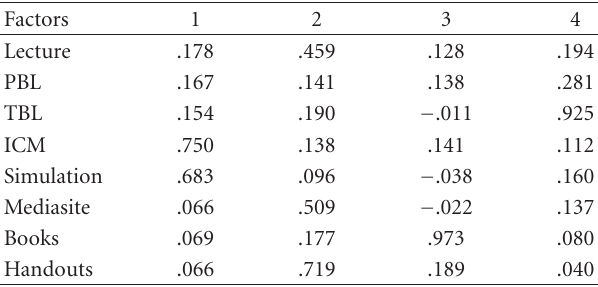
Table 2: Maximum-likelihood factor analysis of the 8 learning modalities, 4-factor varimax rotation. N = 198 students.